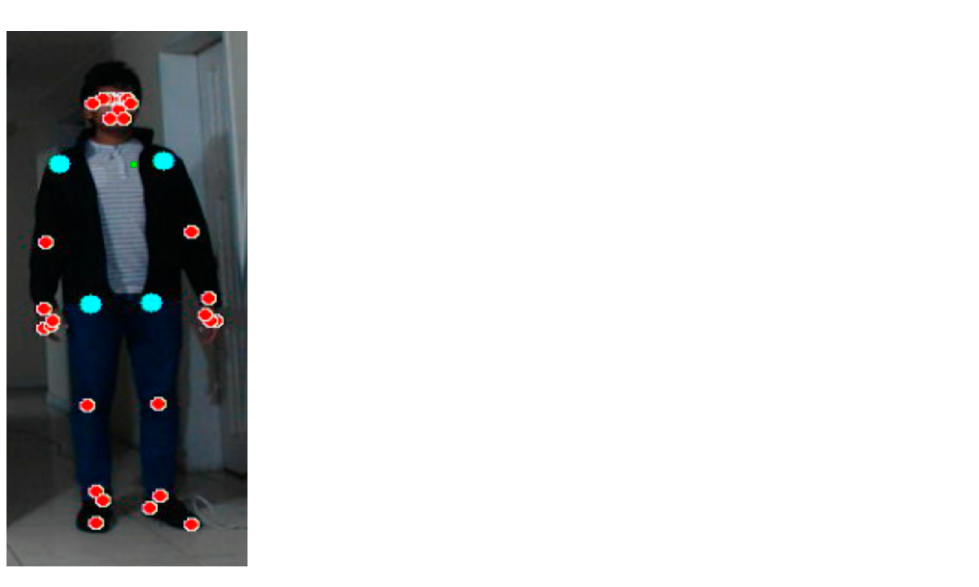
Figure 3. Flowchart for fall detection.